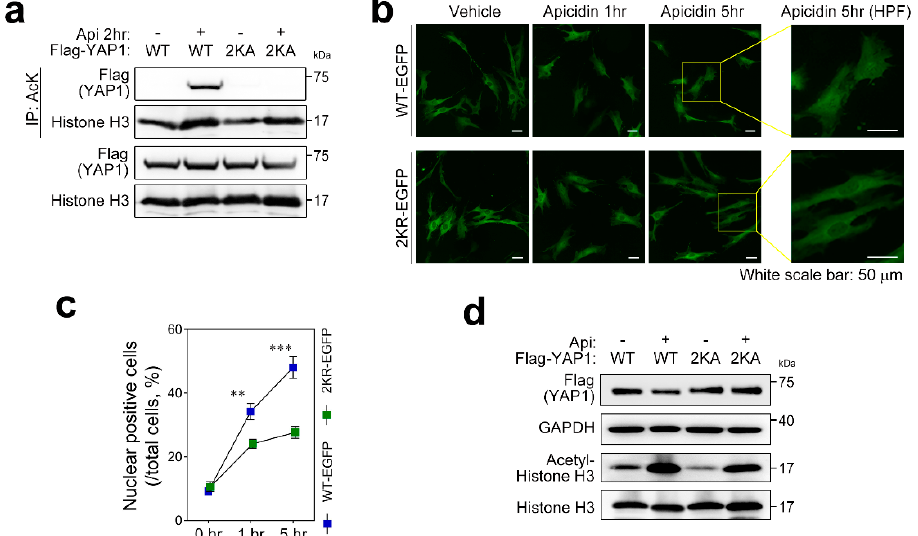
Figure 4. Lysine 494/497 are acetylation targets of YAP1. ( a ) Acetylation of YAP1 was not detected when two lysines, 494 and 497, were mutated (2KA). Output with histone H3 after immunoprecipi- tation with acetyl-lysine was used for internal control. Acetyl-histone H3 delineated intracellular effect of apicidin treatment. ( b , c ) Acetylation facilitated nuclear localization. Enhanced green fluo- rescent protein (EGFP) was fused at the C terminus of YAP1 to visualize location of YAP1. Wildtype YAP1-EGFP started to accumulate in the nucleus as early as 1 h after treatment with apicidin, which was greatly increased after 5 h. Nuclear targeting of the acetyl-dead form of YAP1 was significantly lower than that of wild-type. HPF, high-power field. ( d ) Acetyl-dead mutant of YAP1 remained intact even in the presence of apicidin. Simultaneous treatment with apicidin and cycloheximide failed to degrade acetylation-resistant mutant of YAP1, while wildtype YAP1 was cleared. The gray circle indicates vehicle (or tet-off) condition, and the red rhombus denotes doxycycline (or tet-on) treatment. ( c ) Two-way ANOVA and Tukey’s HSD multiple comparison were performed. ** p < 0.01, *** p < 0.001.